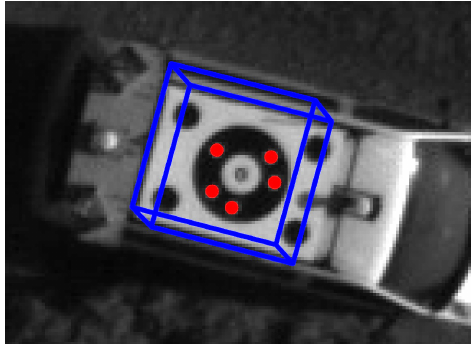
Figure 4: A portion of an aerial image of the mapKITE terrestrial vehicle with the optical target. The red dots mark the identified points for the PnP problem. A cube was overlayed on the image based on the extracted target 3D position and orientation.